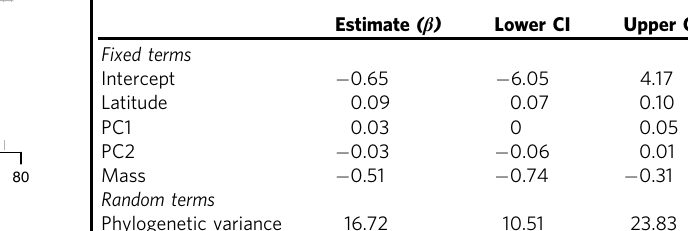
Fig. 3 Relationships between migratory strategies and life history traits and distribution. Migratory propensity as a function of mass for a fl yers, b swimmers and c walkers; and as a function of d PC1 (fast – slow continuum) and e absolute latitude ( n = 1296 species). The solid line corresponds to the median predicted values from the posterior distribution from the Bayesian phylogenetic probit mixed-effects model. Circles represent the proportion of migratory species in each x axis bin. Vertical lines represent the position of each species along the x axis as a function of their migratory strategy.